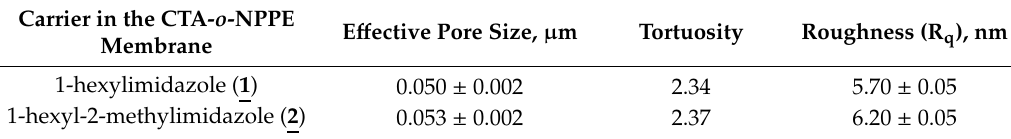
Table 2. AFM characterization parameters for PIM doped with 1-alkyl-imidazole. Carrier in the CTA- o -NPPE Membrane